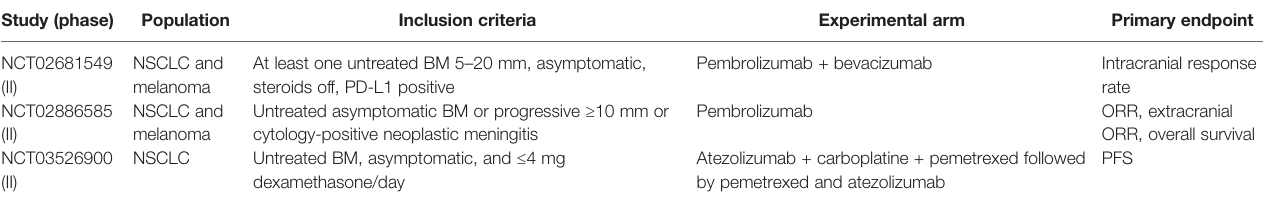
TABLE 1 | Ongoing clinical trials with immune checkpoint inhibitors in NSCLC patients with untreated brain metastases. Study